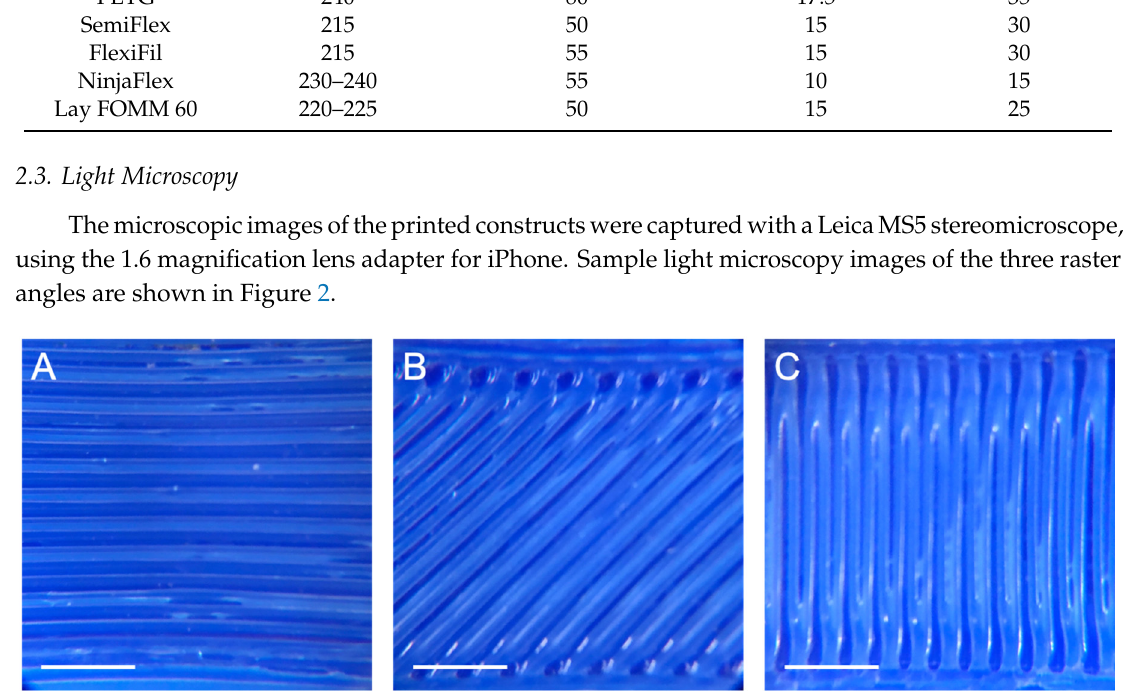
Figure 2. Light microscopy images of FlexiFil printed with raster angles of ( A ) 90°, ( B ) 45° and ( C ) 0°. Scale bar = 2.5 mm.